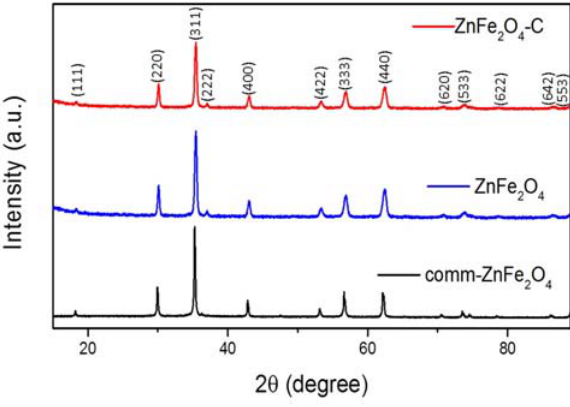
Figure 3. XRD patterns of the self-prepared ZnFe O /C material and of the commercial ZnFe Fe 2 4